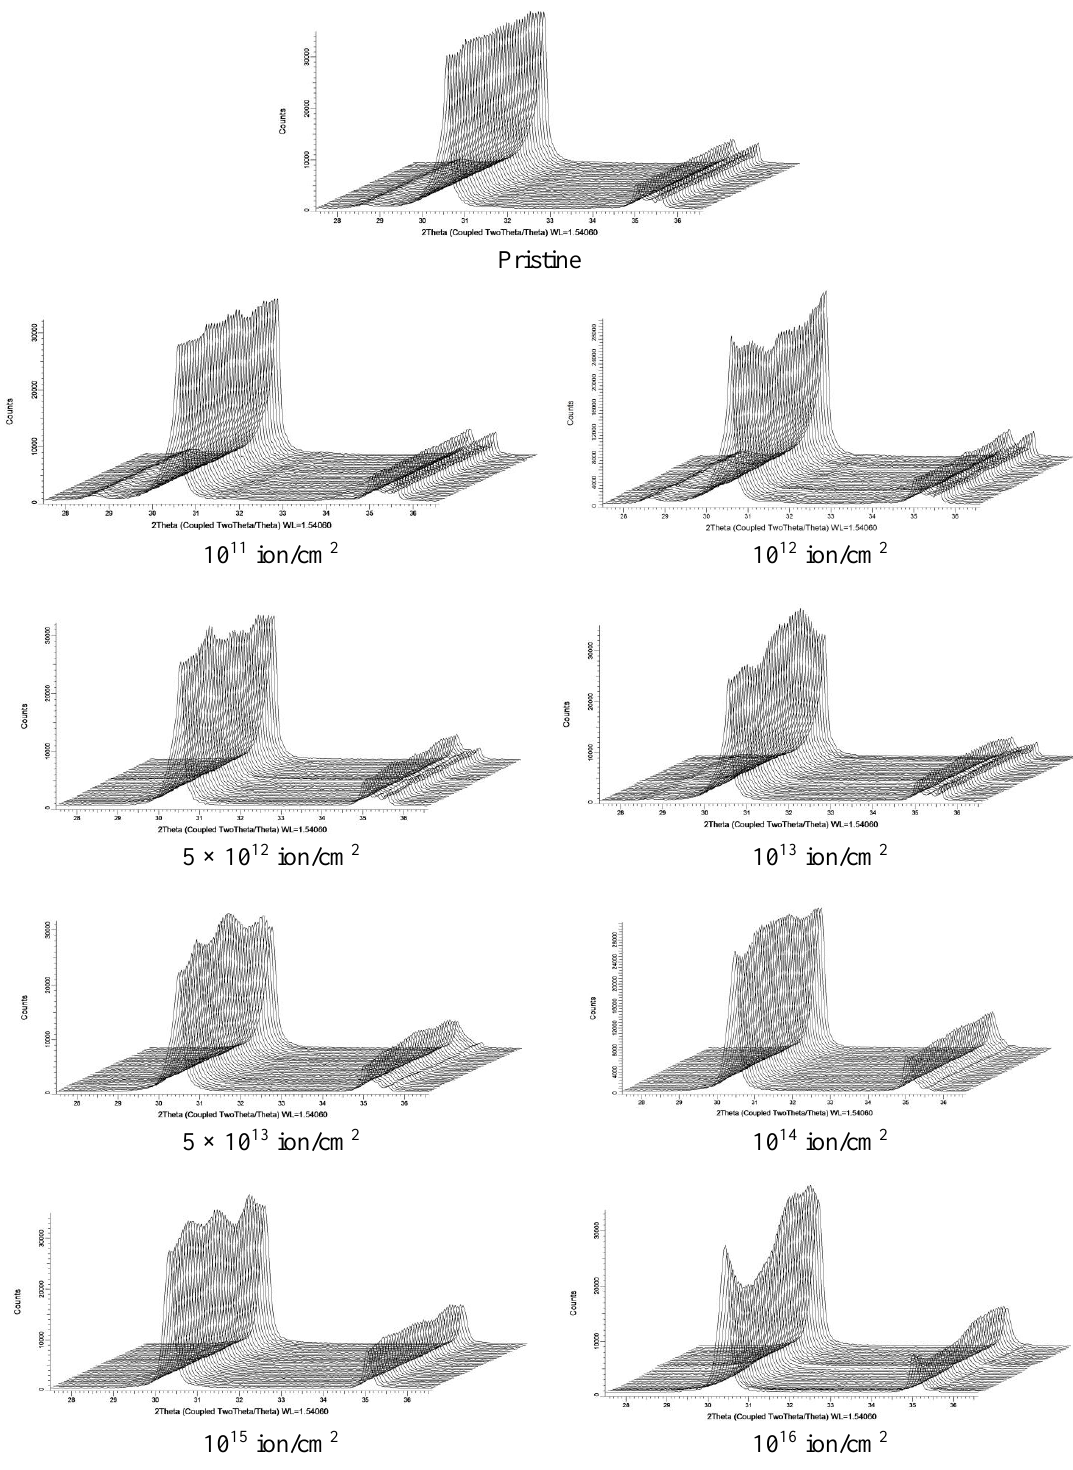
Figure 6. Resulting X- ray diffraction patterns of the studied samples in the survey geometry of φ = 0 –